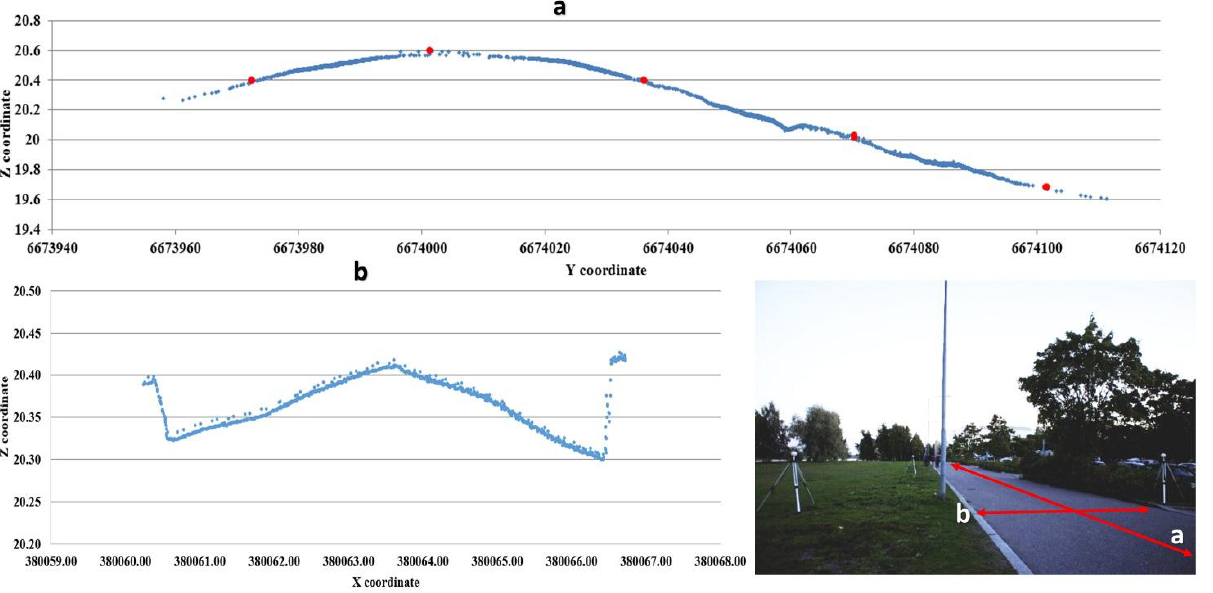
Figure 1. Profile view of the Otaranta road center line ( a ) and cross-section ( b ). Z coordinates are presented in GRS80 (Geodetic Reference System 1980), Y and X coordinates in ETRS-TM35FIN, units expressed in meters (positions of poles are marked with red dots in picture